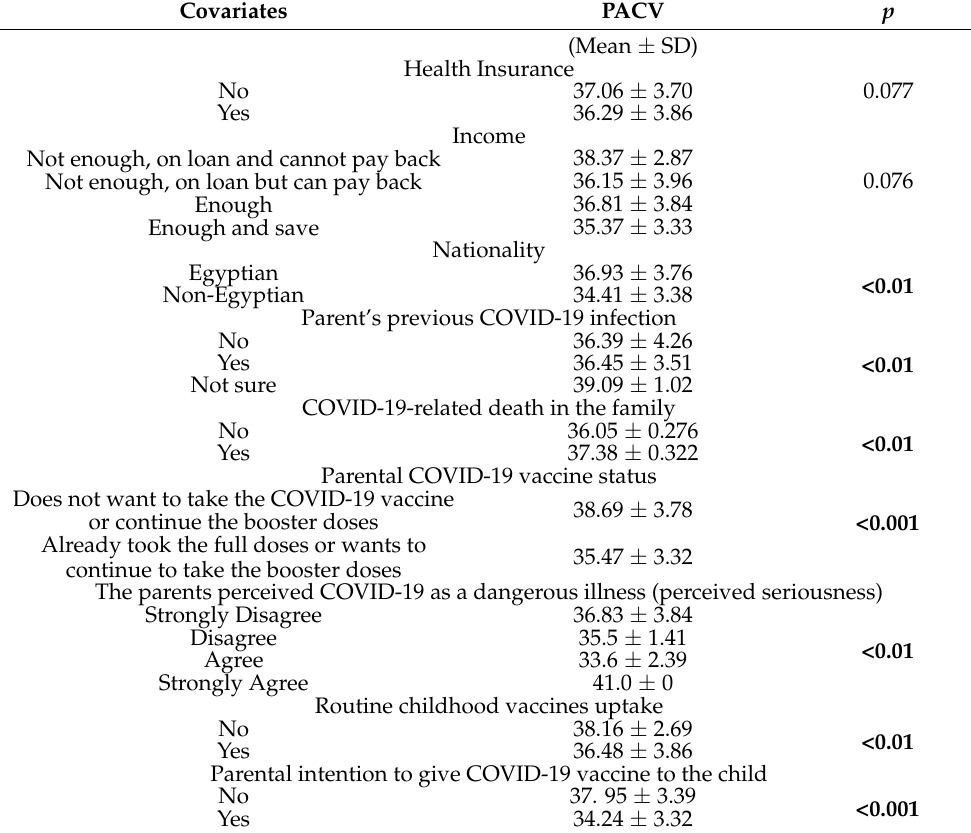
Not enough, on loan and cannot pay back